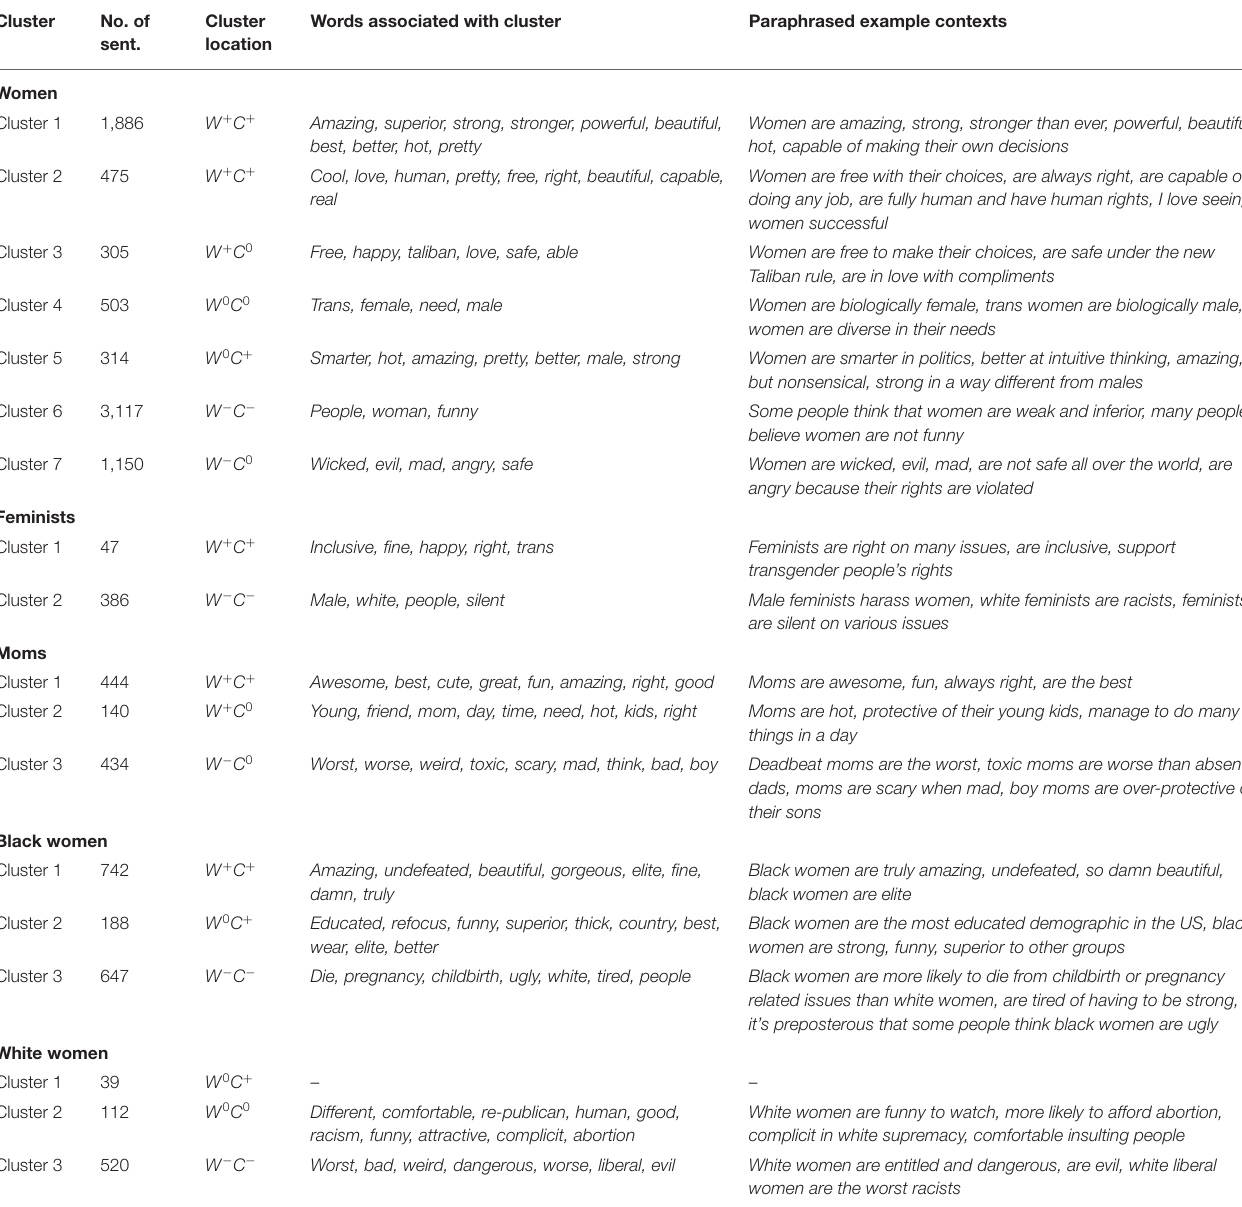
TABLE 6 | Words associated with different clusters and paraphrased example contexts where the words appear for each women target group. Cluster No. of